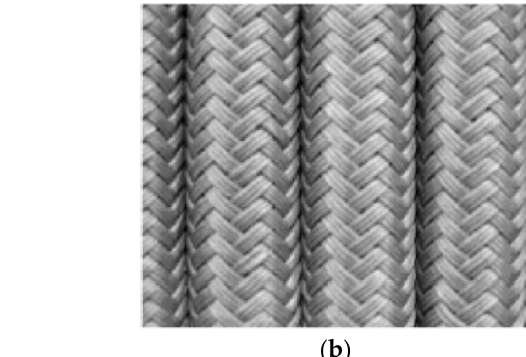
Figure 2. Comparison of the non-braided and braided fabric layers. ( a ) The typical structure of a hose pump hose, in which the fabric layers tend to be non-braided. ( b ) The typical braided fabric layers.